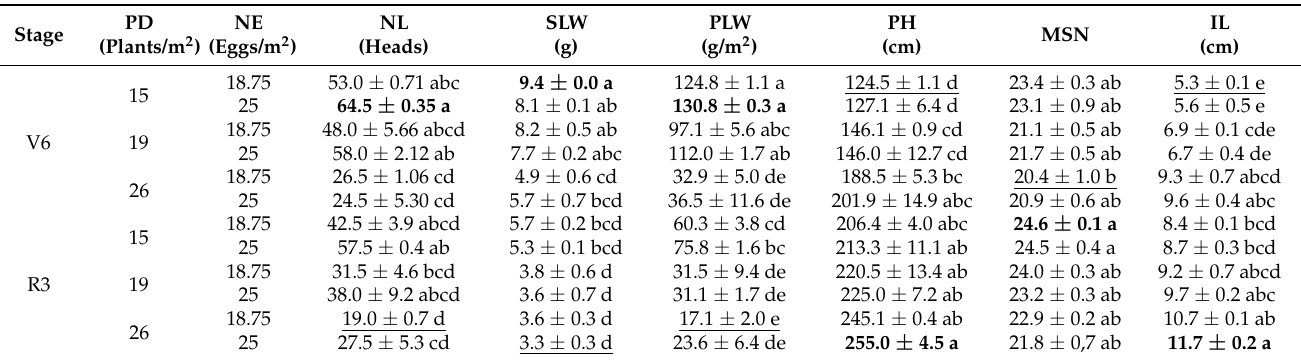
Table 4. Multiple comparisons of growth indicators of C. bilineata tsingtauica and soybean plants among different treatments in spring sowing.